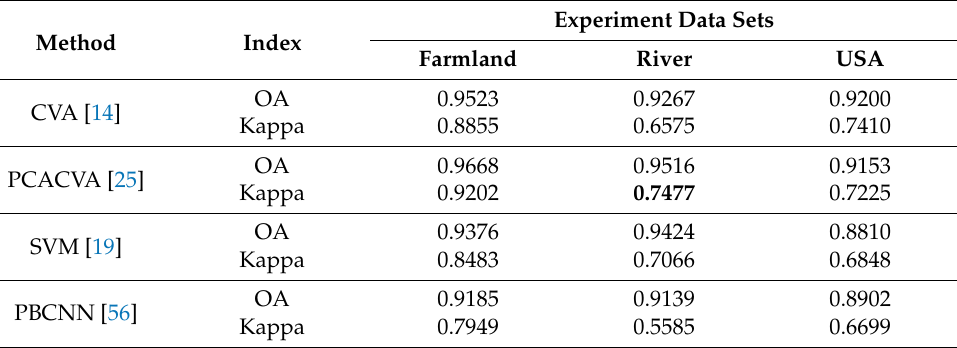
Figure 5. CD result on River. ( a ) CVA [14] ( b ) PCACVA [25] ( c ) SVM [19] ( d ) PBCNN [56] ( e ) GETNET [37] ( f ) HybridSN [41] ( g ) SCNN-S ( h ) SSCNN-S ( i ) Ground truth. Table 1. Experimental results of different algorithms on three data sets (the optimal results are highlighted in